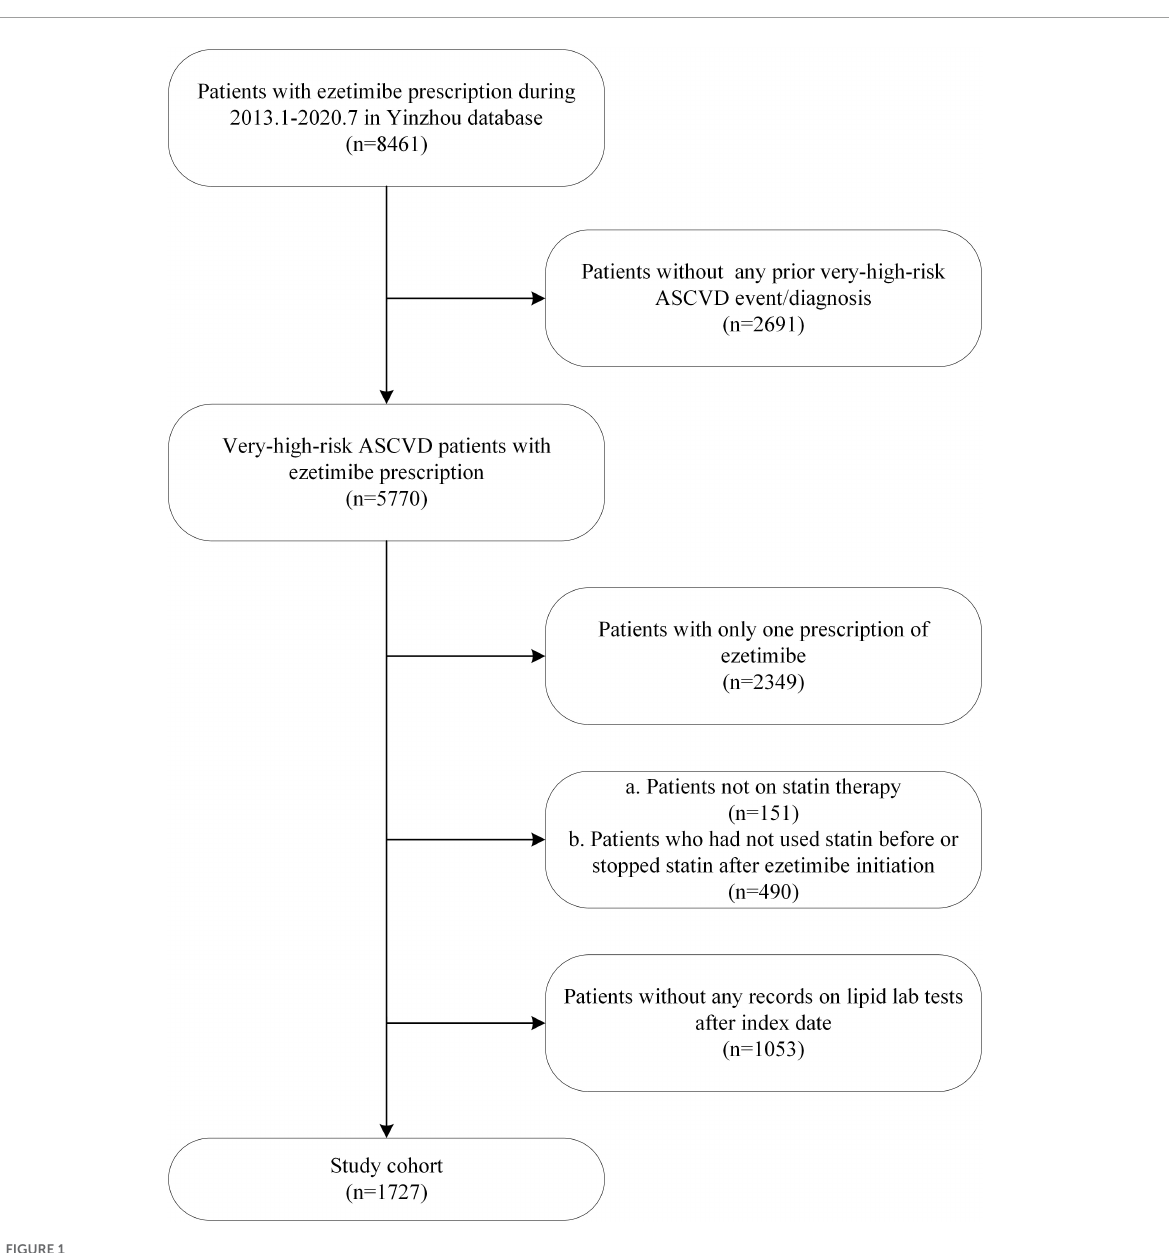
during each follow up year showed higher LDL-C values and lower achievement rates after statin plus ezetimibe ( Table 2